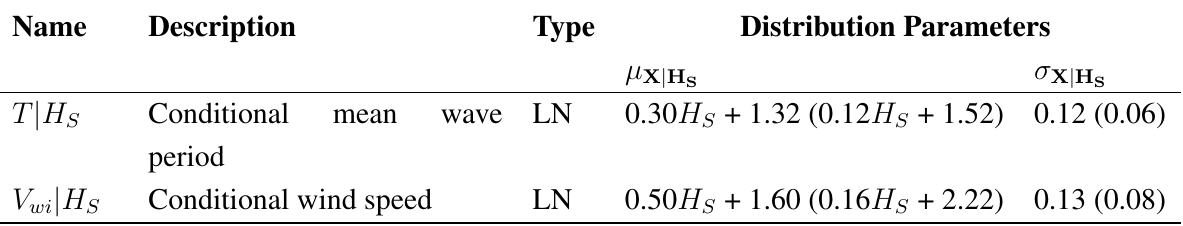
Table 6. Conditional distribution parameters for mean zero-crossing wave period T and 10-min mean wind speed V . The distribution parameters are based on a 30-year hindcast wi simulation [21]. Values in () are only valid for Case 1. LN, log-normal